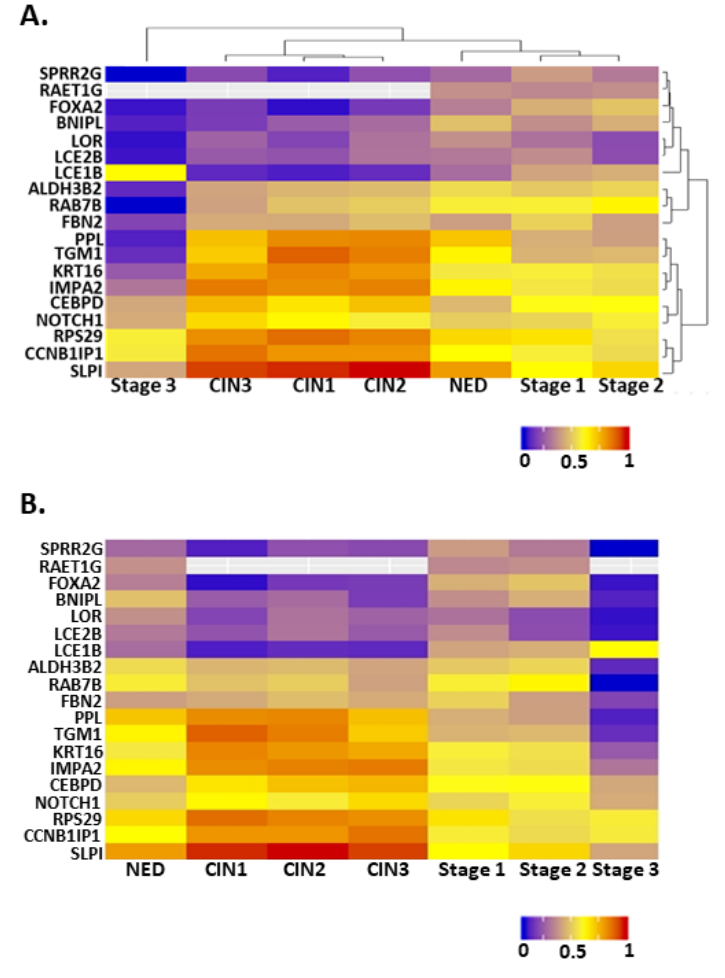
Figure 2. Heat maps showing the expression of NFX1-123-responsive genes at different stages of cervical cancer development. ( A ) A heat map organized by two unsupervised cluster analyses of the data. Dendrograms on the top and right show the results of these analyses. ( B ) A heat map organized along the x -axis such that the least transformed tissues are on the left and the most transformed are on the right. The y -axis lists genes in the same order as in ( A ). For all, warmer colors represent higher expression, while cooler colors represent lower expression. NED = no evidence of disease, CIN1 = cervical intraepithelial neoplasia grade 1, CIN2 = cervical intraepithelial neoplasia grade 2, and CIN3 = cervical intraepithelial neoplasia grade 3, Stage 1 = stage 1 cervical cancer, Stage 2 = stage 2 cervical cancer, and Stage 3 = stage 3 cervical